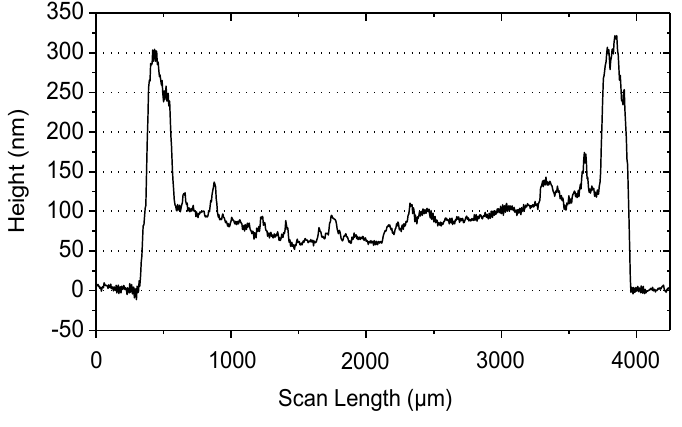
Figure 11. Profile scan of the µ -dispensed semiconductor, FS111, across the center of a